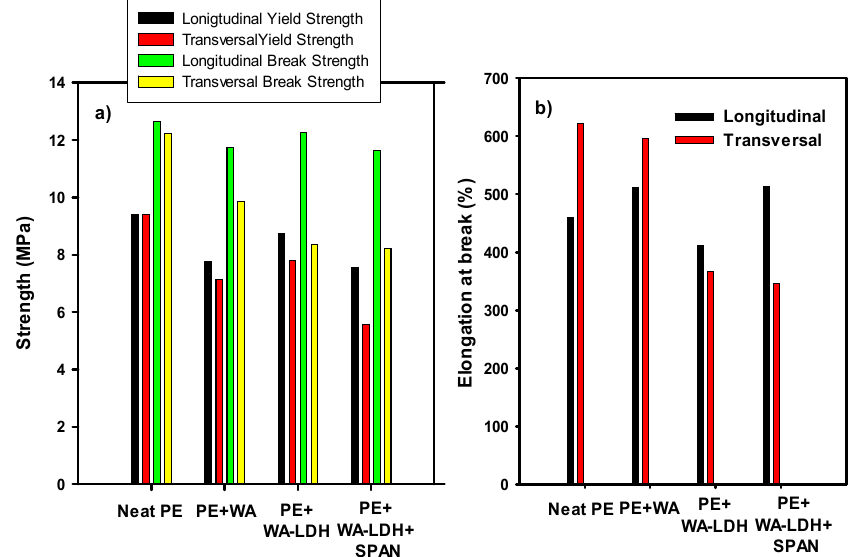
Figure 7. Mechanical properties of Neat PE, PE + WA, PE + WA-LDH, and PE + WA-LDH + surfactant are depicted. In ( a ) the longitudinal and vertical yield and tensile strengths are represented, and in ( b ) the longitudinal and vertical nominal deformation.